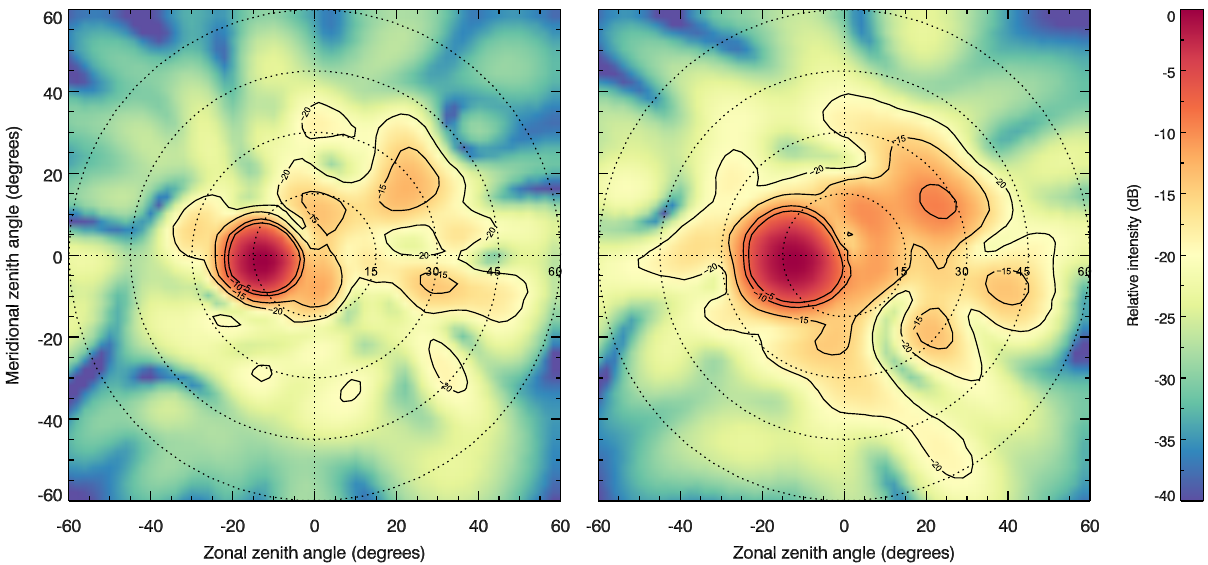
Figure 2. Modelled transmit (left) and receive (right) polar diagrams for the antenna configurations in Fig. 1, and used for the HDI ex- periments. Phasing has been applied to steer the beam away from the zenith; see text for details. The models were produced in EZNEC v. 5.0.63.